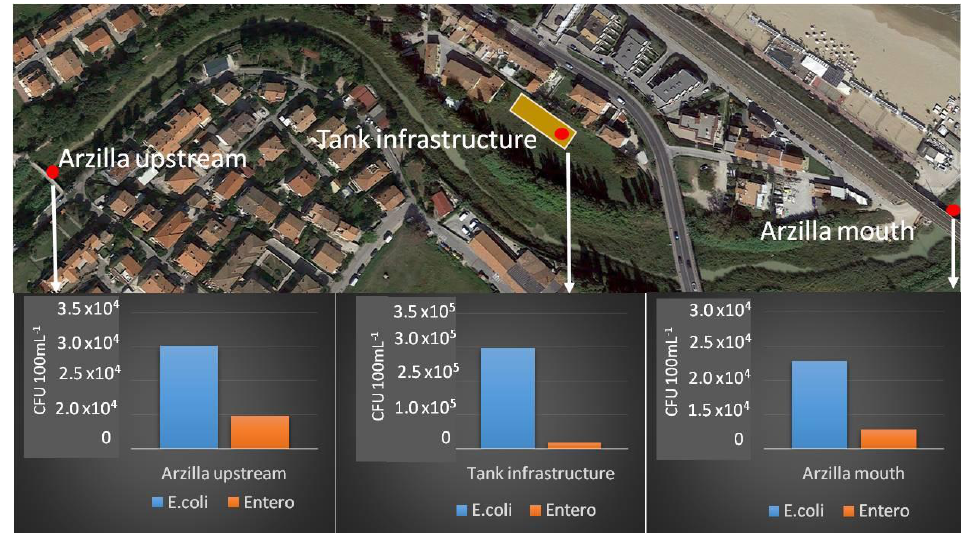
Figure 6. Escherichia coli ( E. coli ) and intestinal enterococci (Entero) measured at the three sampling sites (Arzilla River, upstream; tank; and Arzilla River, mouth) after an intense rainy event (27 mm 30 min −1 ).